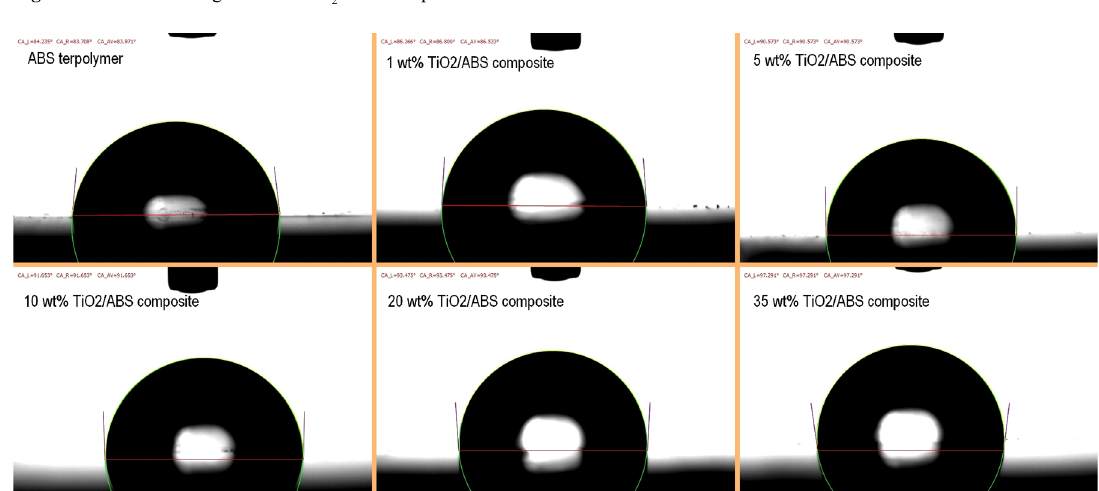
Figure 8. The contact angles of the TiO